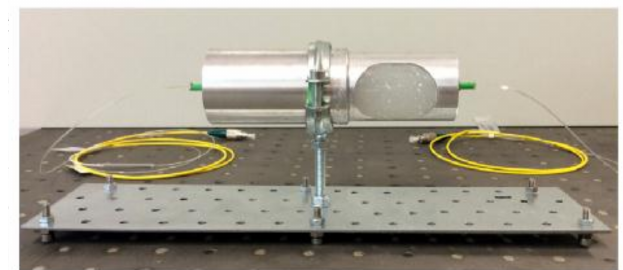
Figure 25. Prototype of simultaneous measurement of hydrostatic pressure and temperature based on polymer cylinder filling in a dual chamber system (reprinted from Schenato et al. [58] with permission of Elsevier; copyright (2016)).